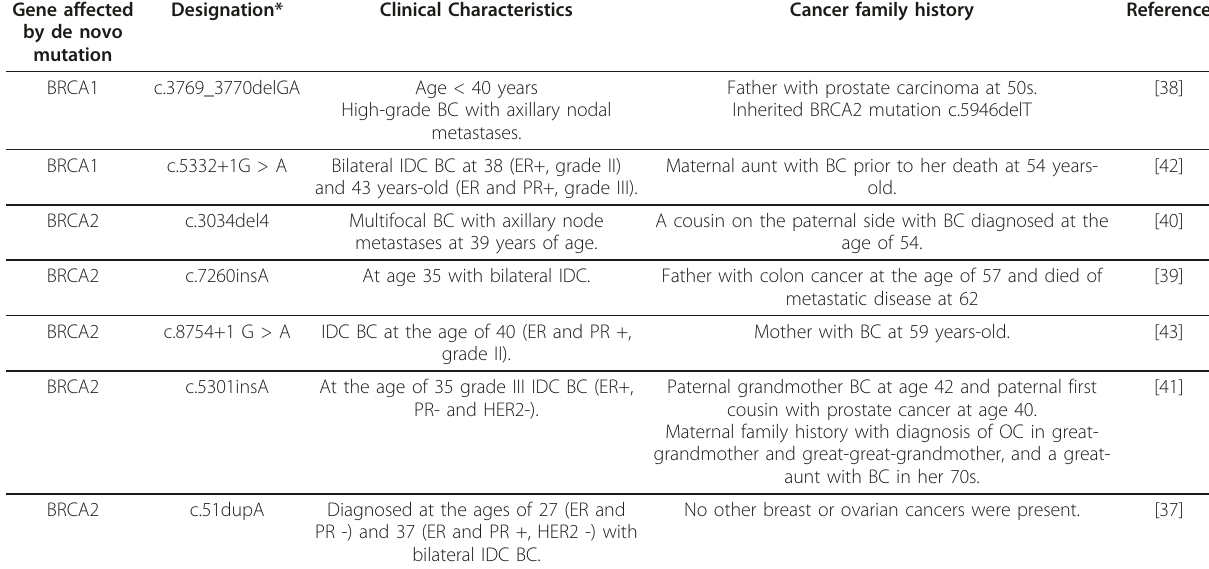
Table 1 BRCA1 and BRCA2 de novo